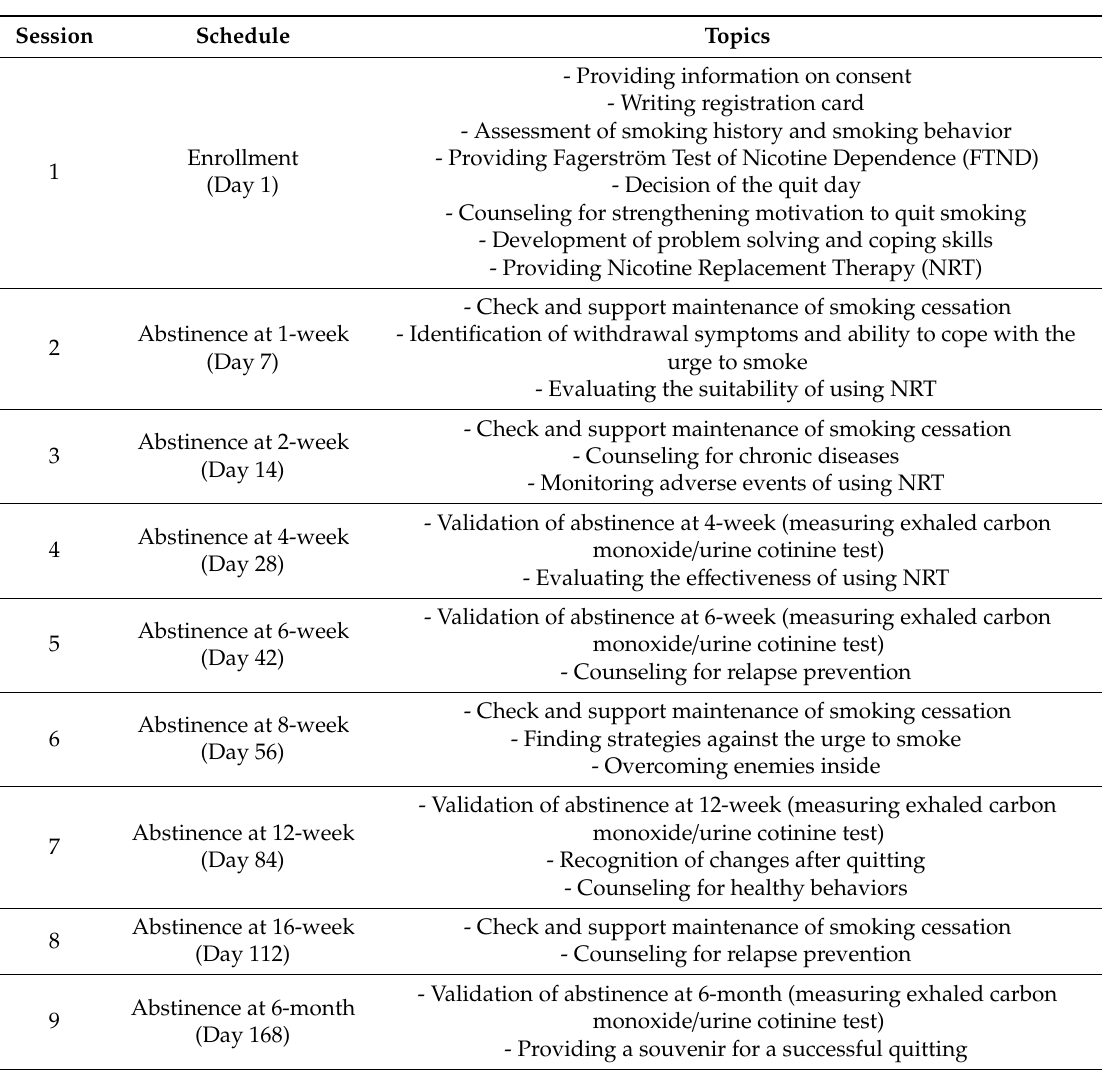
Table 1. Manual for